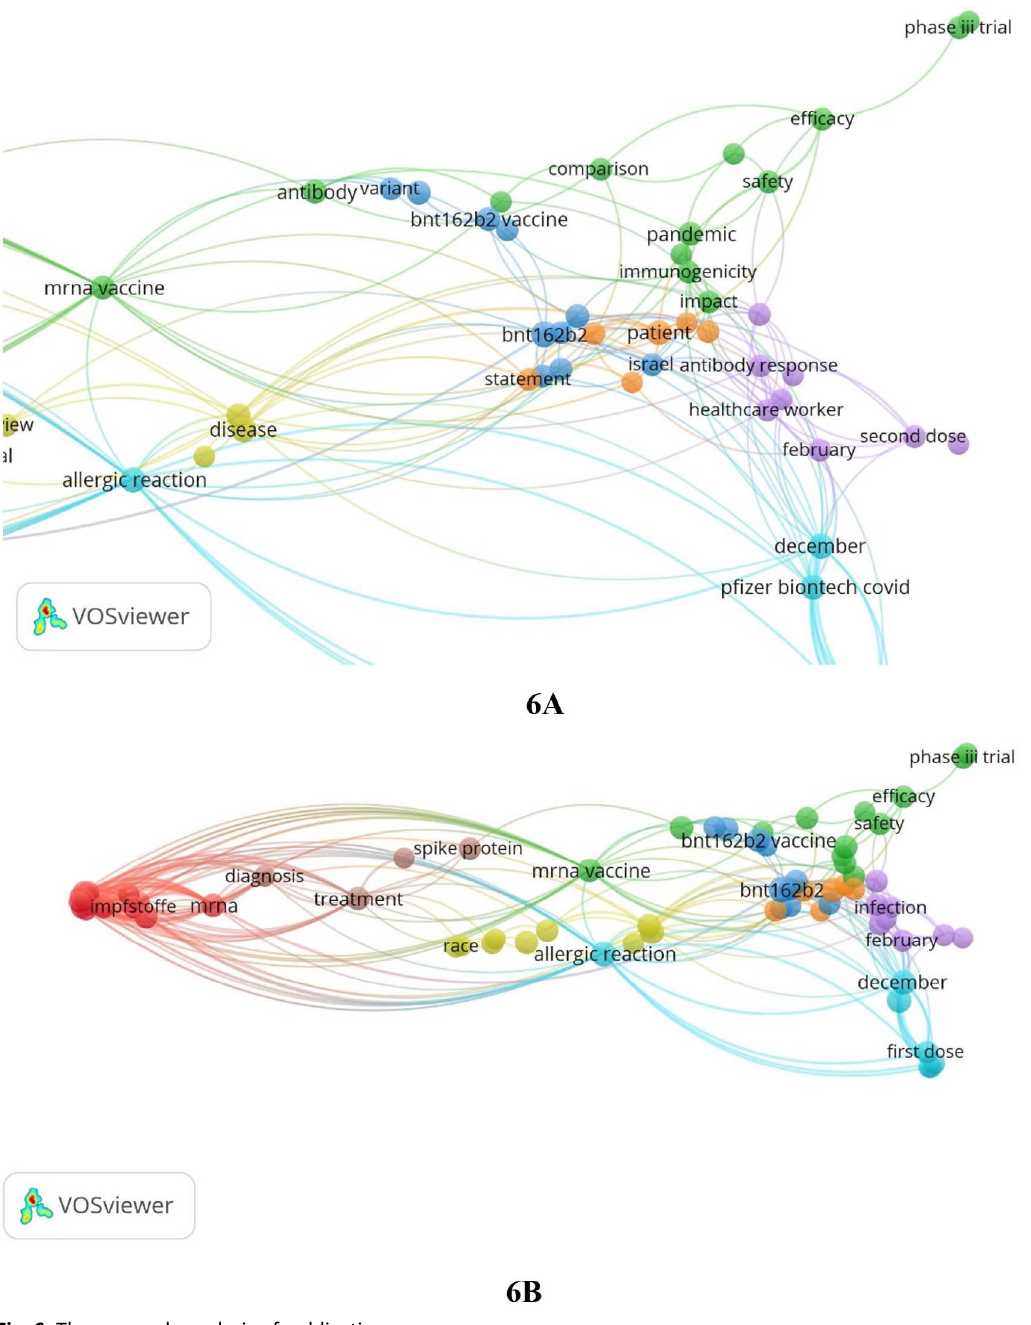
Fig. 6. The co-words analysis of